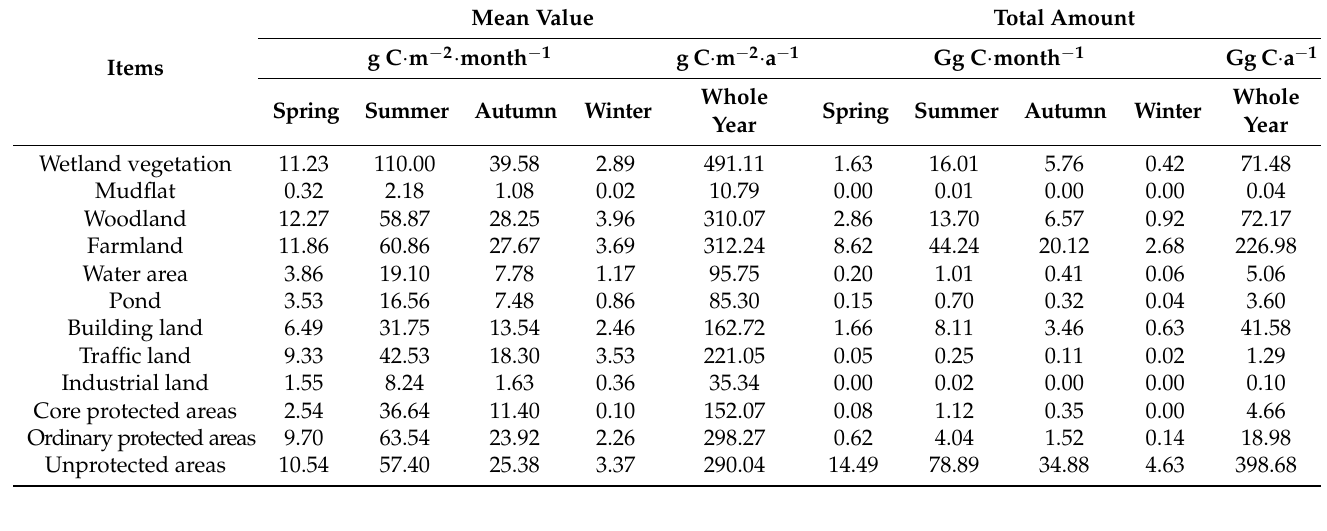
Table 3. NPP results of different land-cover and protected area types in different seasons and the whole year in 2016–2017.